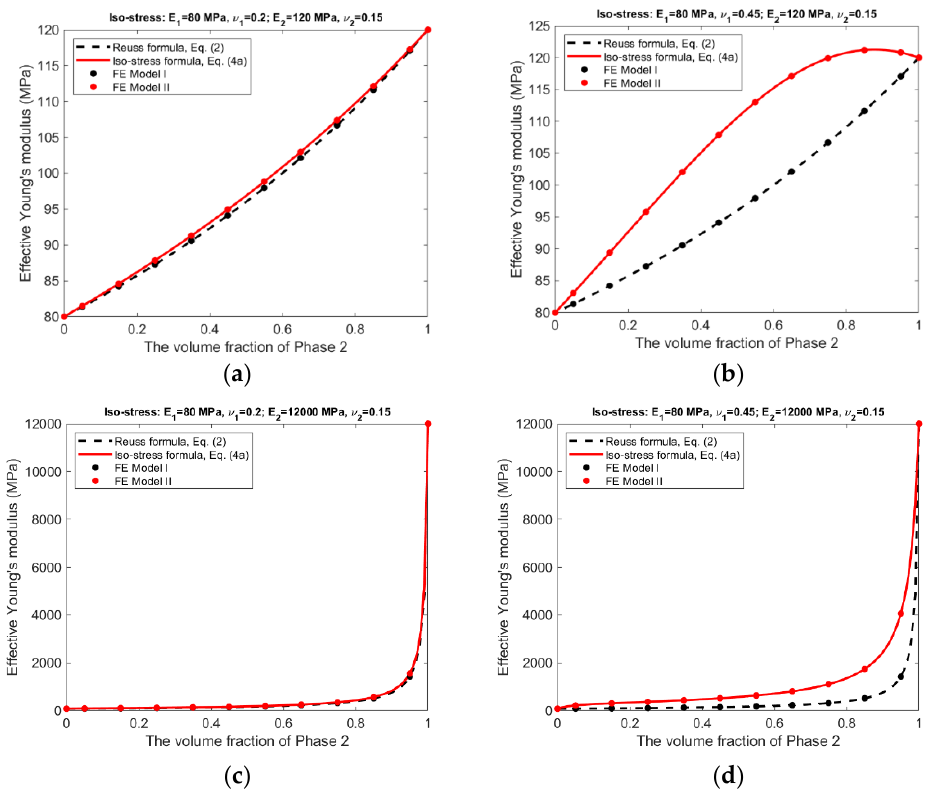
Figure 8. Iso-stress condition—Effective Young’s moduli predicted by analytical formulas and FEM. ( a ) Composite #1. ( b ) Composite #2. ( c ) Composite #3. ( d ) Composite #4.